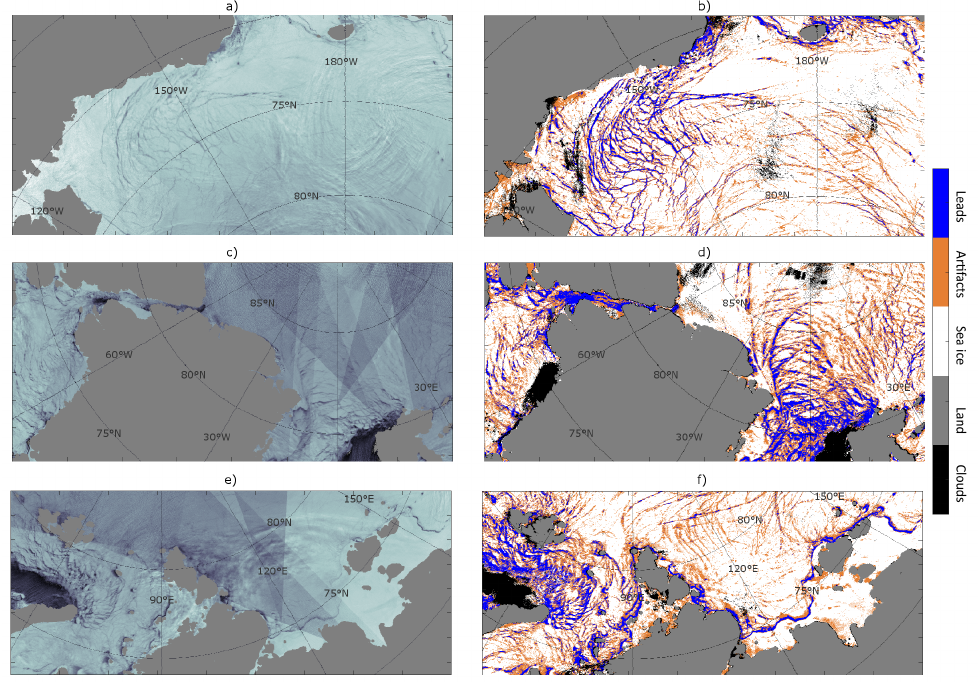
Figure 2. Comparison of swath-normalized and daily averaged reflectance (left column, MODIS channel 2) and FCAF output data (right column), 4 April 2009, for ( a,b ) the Beaufort and Chukchi Seas; ( c,d ) the Greenland Sea, northern Baffin Bay and northern Fram Strait; ( e,f ) in the Kara and Laptev